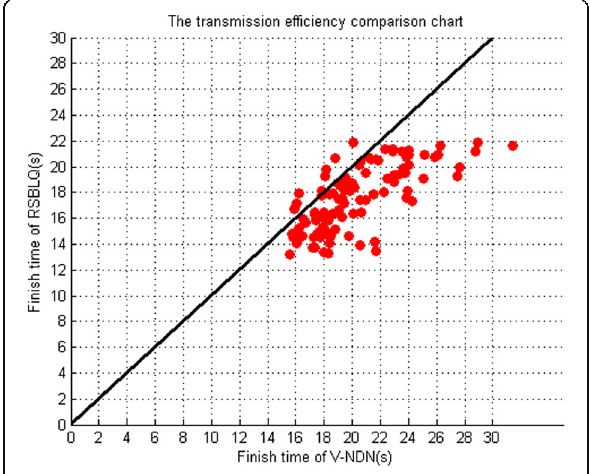
Fig. 11 The transmission efficiency comparison with V-NDN